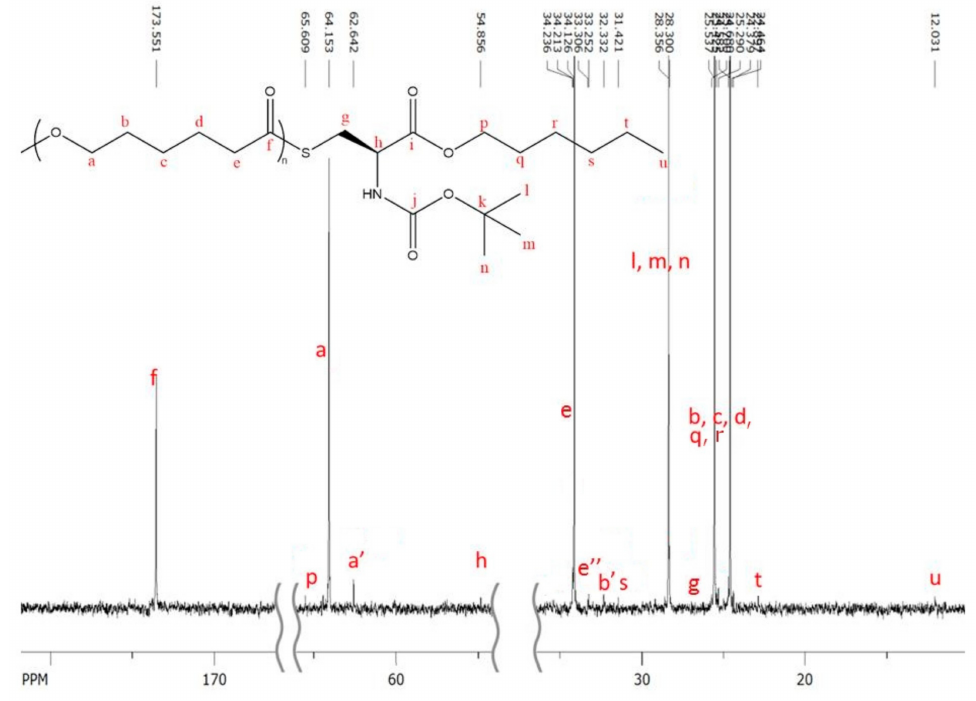
Figure 3. 13 C-NMR of polymerization product between CL and 10 mol % of N -Boc Cys